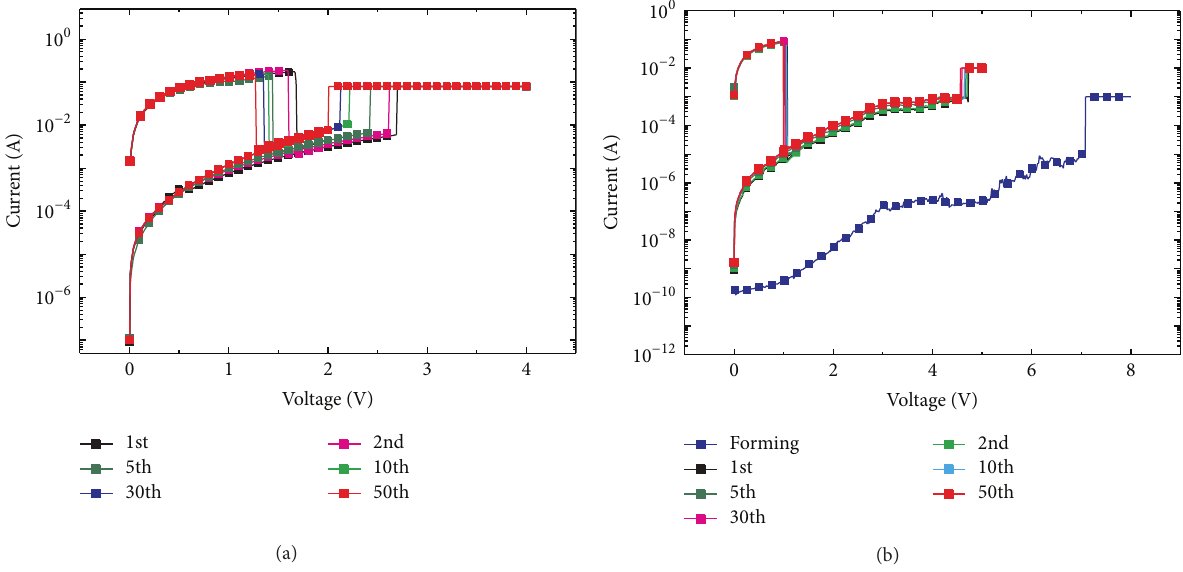
Figure 2: Typical resistive switching characteristics of (a) Pt/TiO 2 /Pt and (b) Pt/TiO 2